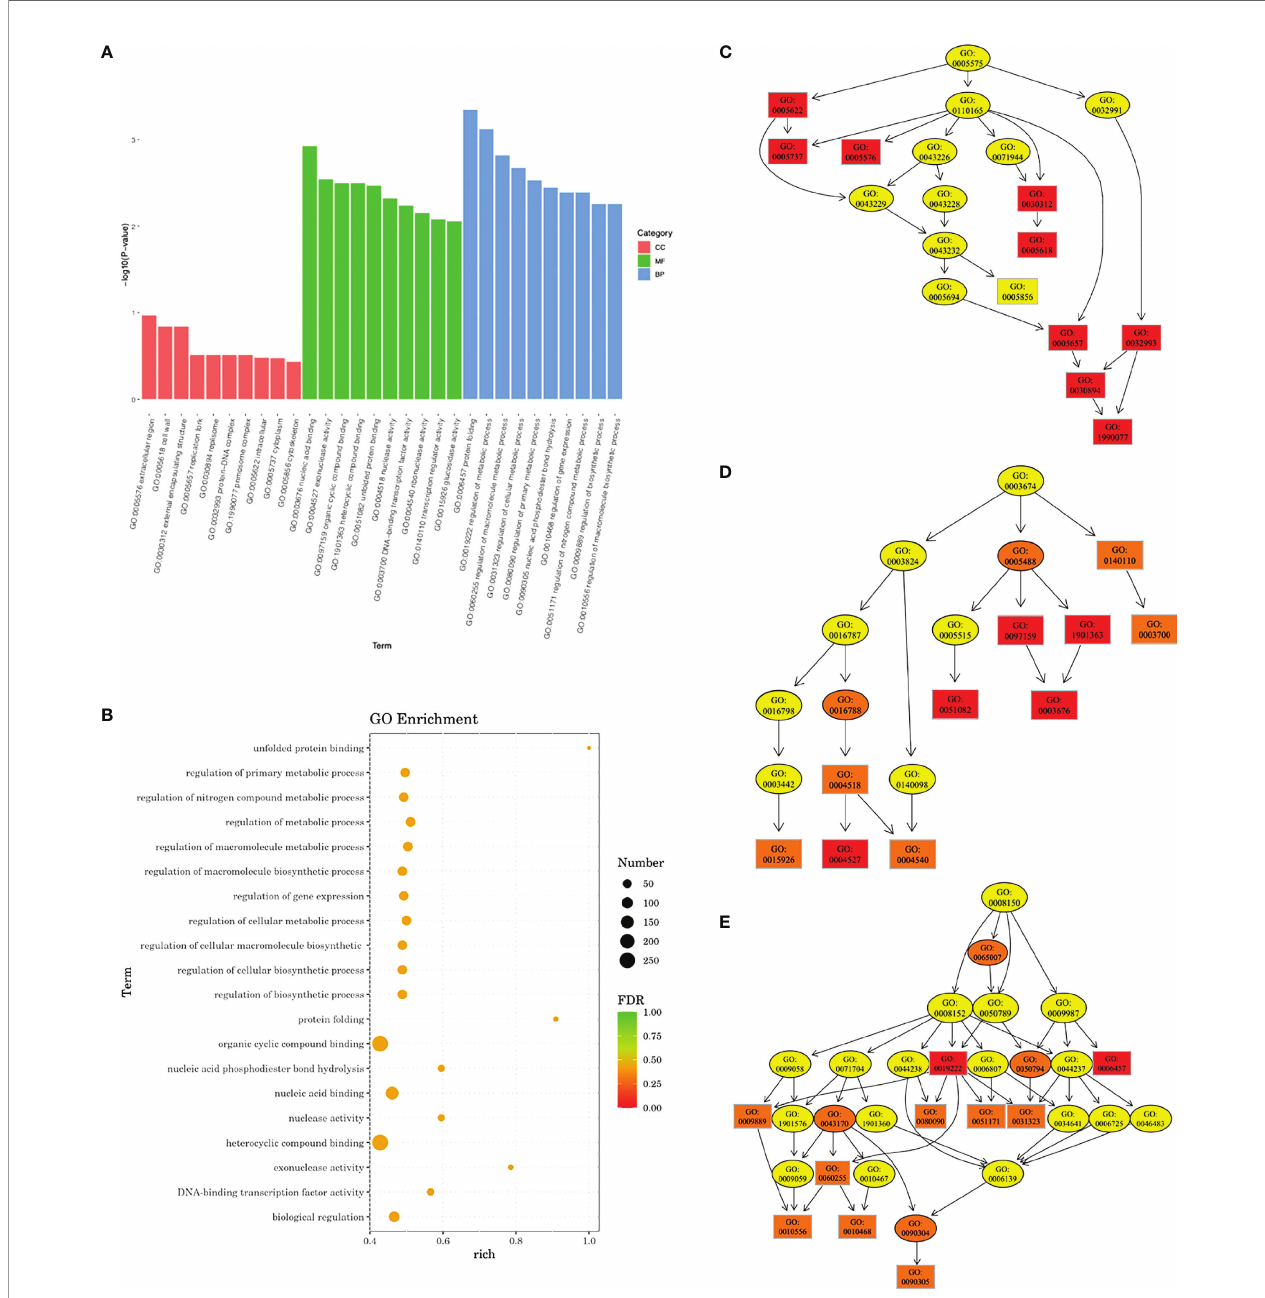
FIGURE 7 | Gene Ontology (GO) enrichment analysis of transcriptomic pro fi le. (A) Bar plot showing the most signi fi cantly enriched GO terms. CC, cellular component; MF, molecular function; BP, biological process. (B) Rich factors of 20 GO terms with the smallest false discovery rate (FDR) values. Directed acyclic graph (DAG) in cellular component (C) , molecular function (D) , and biological process (E) . Deeper color indicates a higher level of enrichment. GO accession number is